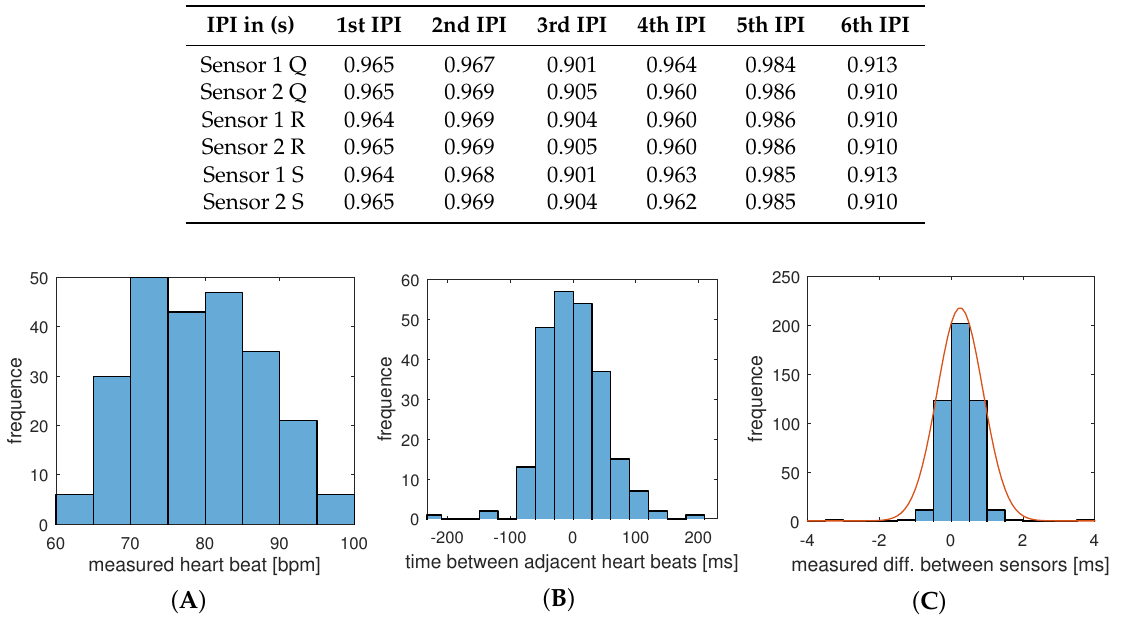
Table 3. Results for two sensors of the C implementation on the BAN.